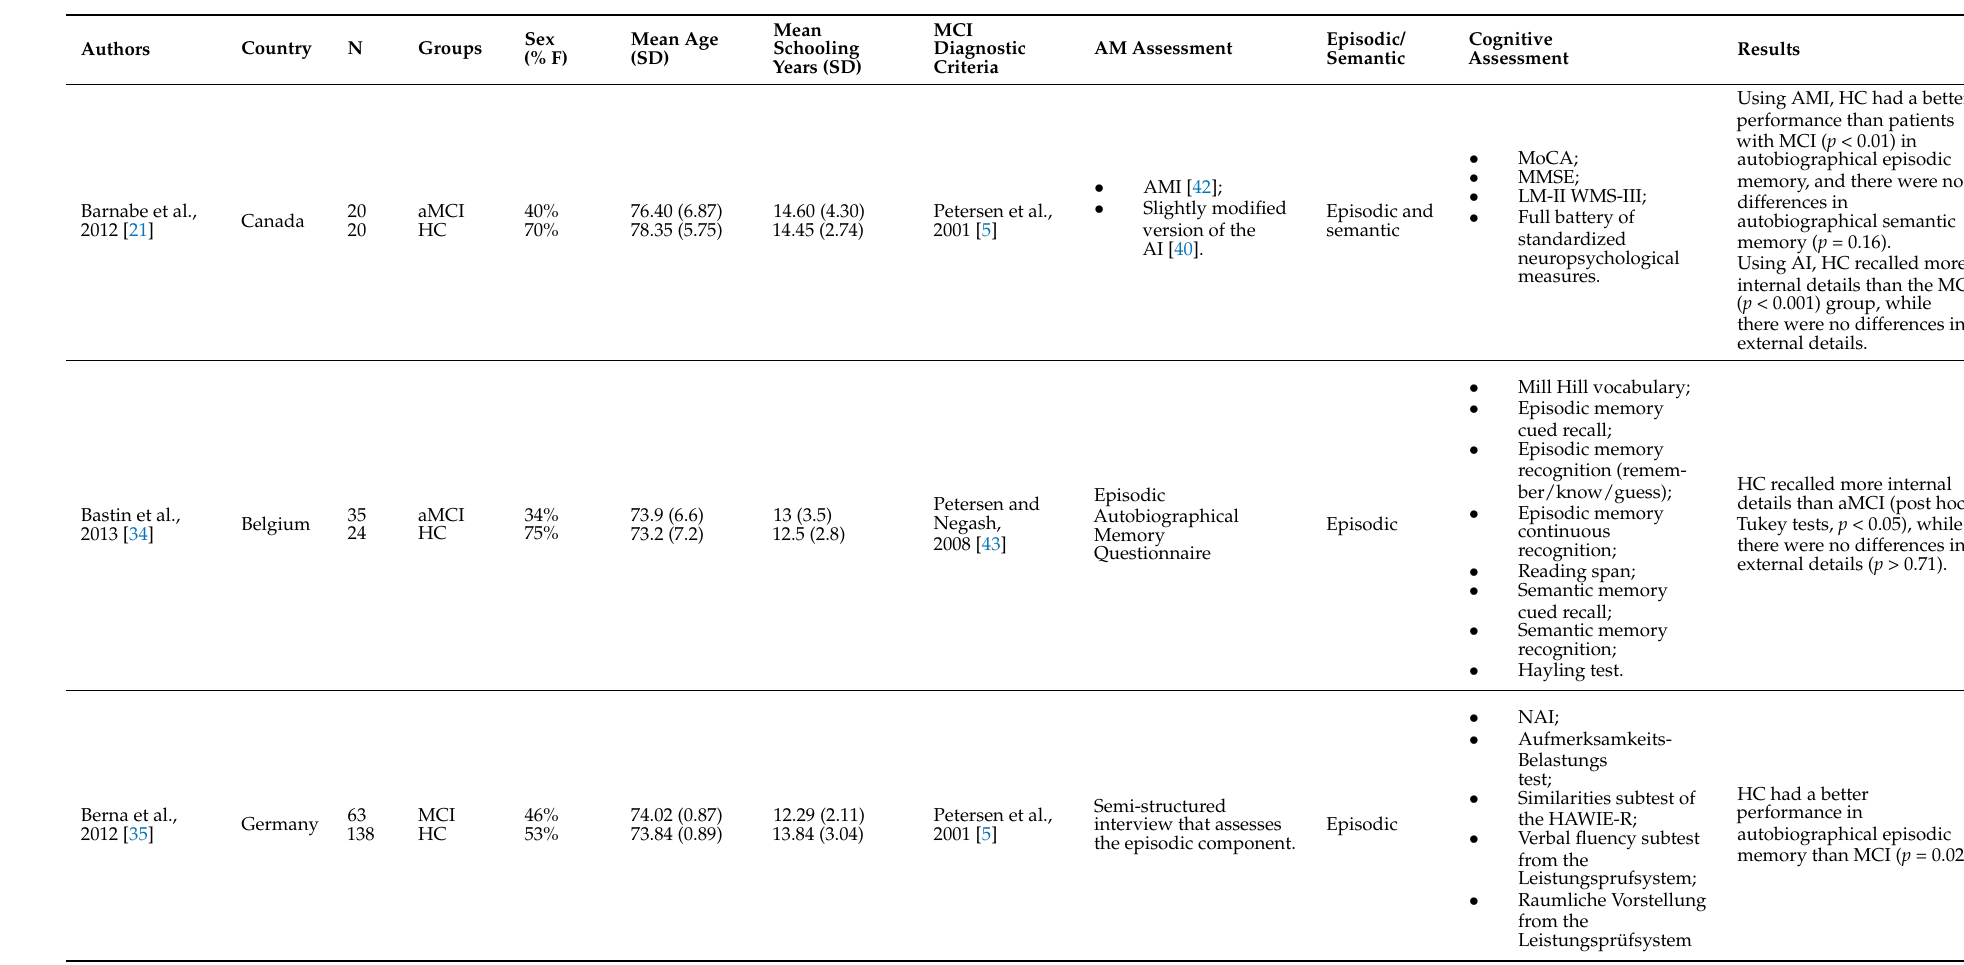
Table 3. Selected studies’